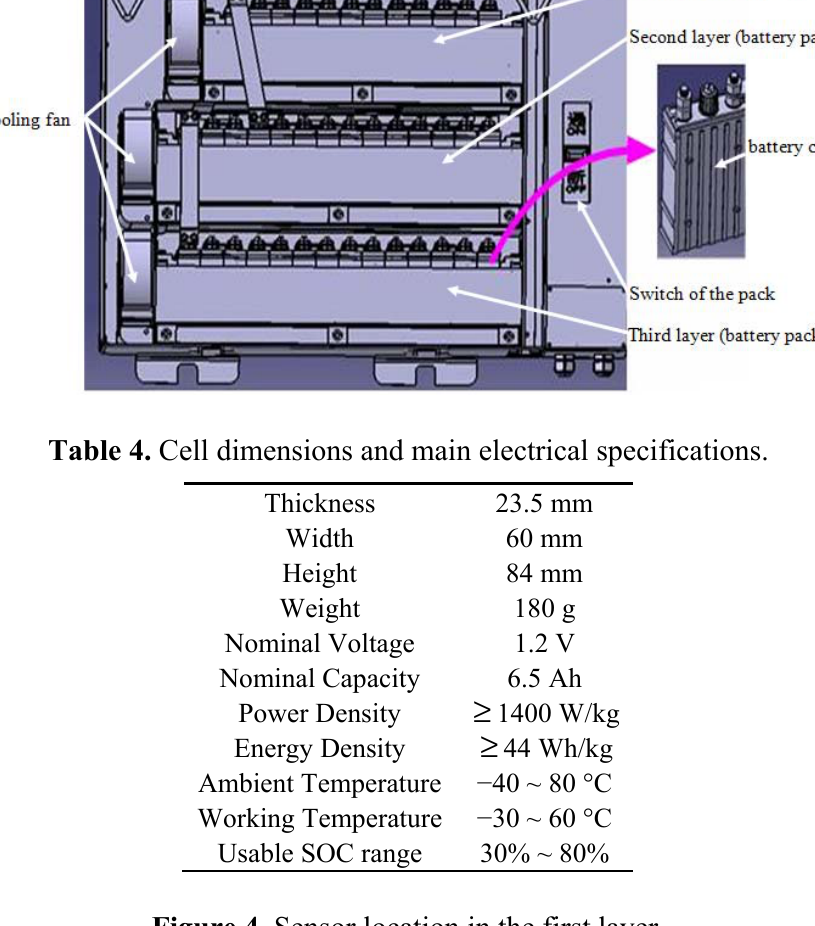
Figure 4. Sensor location in the first